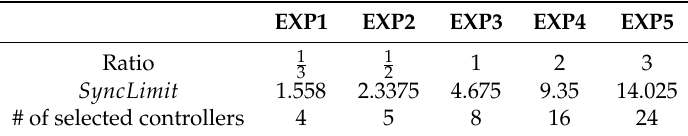
Table 6. Amount of SyncLimit in each